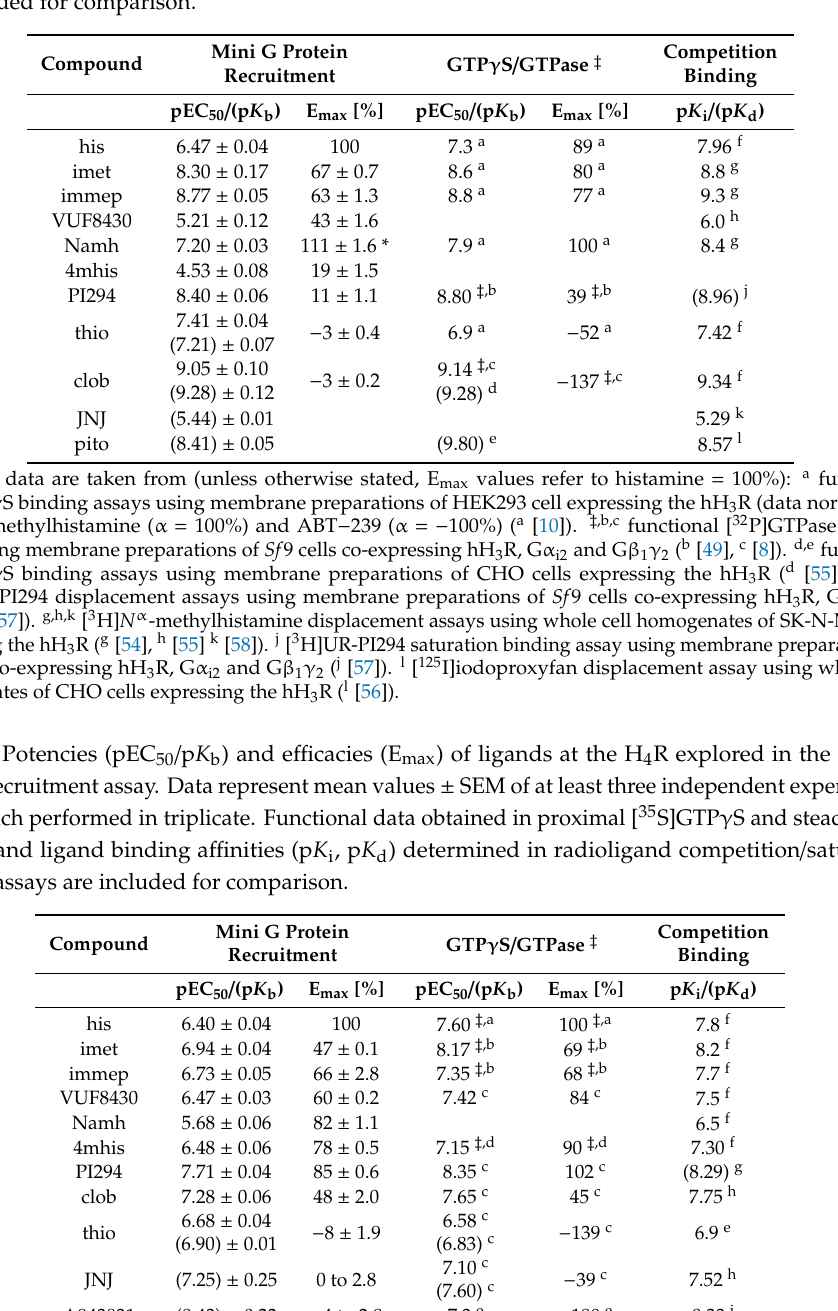
Table 3. Potencies (pEC 50 / p K b ) and e ffi cacies (E max ) of ligands at the H 3 R explored in the mini-Gprotein recruitment assay. Data represent mean values ± SEM of at least three independent experiments ( n ≥ 3), each performed in triplicate. Statistical di ff erences (*) of E max > 100% was tested using a one-sample t-test ( n = 5; α = 0.05). Functional data obtained in [ 35 S]GTP γ S and steady-state GTPase assays and ligand binding a ffi nities (p K i , p K d ) determined in radioligand competition / saturation binding assays are included for comparison.